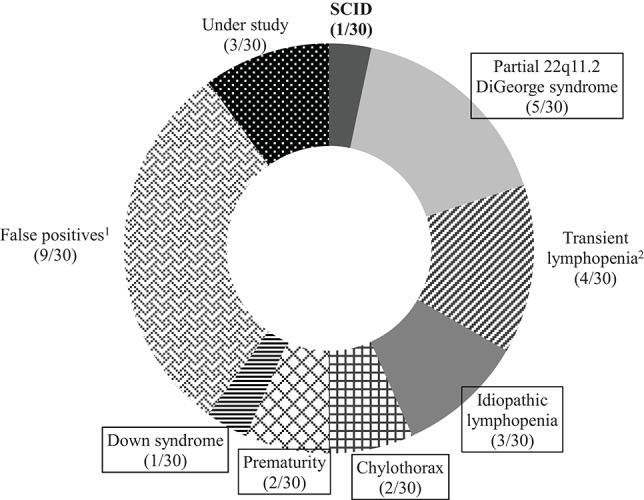
Final diagnoses in patients testing positive in Catalonia (2017–2018). 1False-positives due to initially normal lymphocyte count with normalization of TRECs between 3 and 6 months of life; 2Transient lymphopenia due to initially low lymphocyte count with recovery in the following months. Final diagnosis of the 13 non-SCID lymphopenic patients are now boxed. SCID, severe combined immunodeficiency.